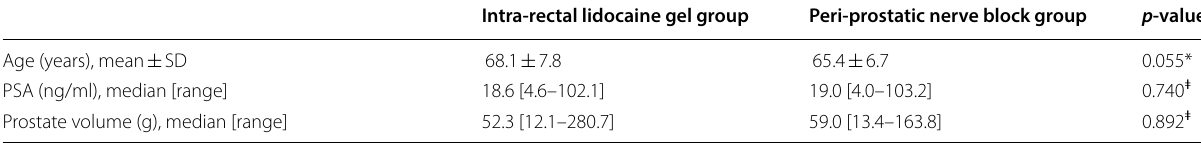
* p -value (independent samples t test) < 0.05 is significant ǂ p -value (Mann–Whitney U test) < 0.05 is significant